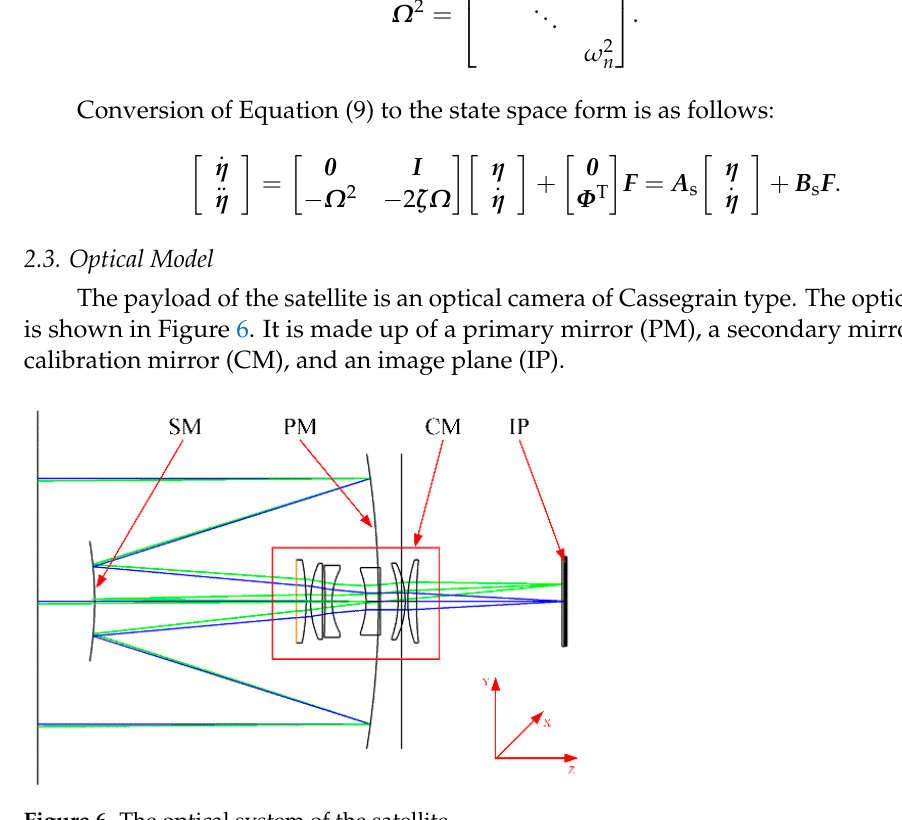
Figure 6. The optical system of the satellite. The disturbance force and tongue will deform the optical component, which